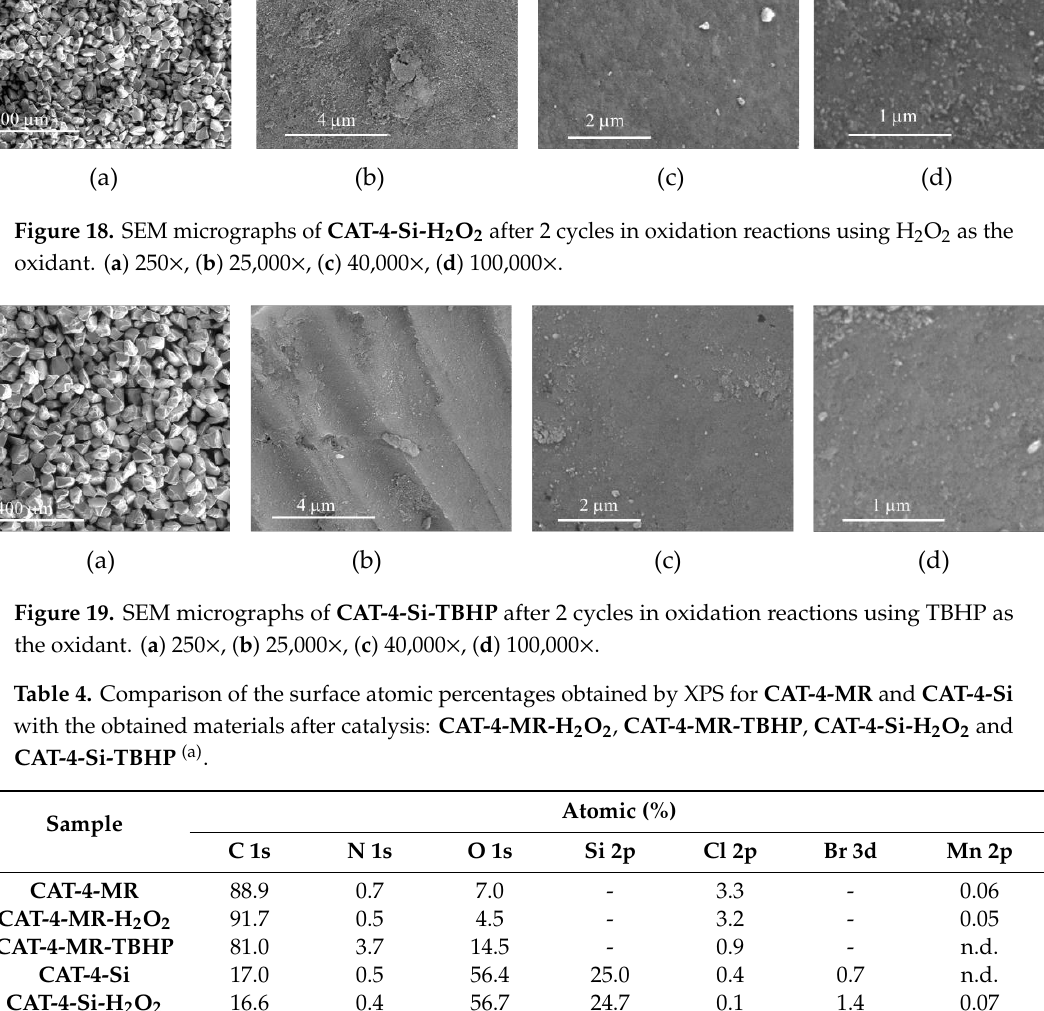
as the oxidant. ( a ) 250×, ( b ) 25,000×, ( c ) 40,000×, ( d ) 100,000×.